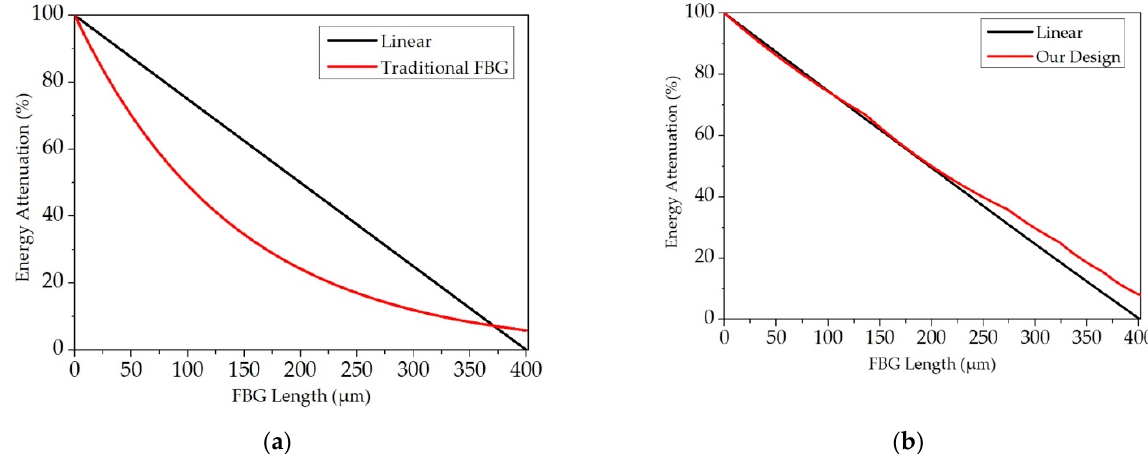
Figure 5 ( a ) The energy attenuation of a conventional grating antenna, where the decay pattern is an exponential decay resulting in less than 50% of the light energy remaining when the light is transmitted to about 100 μ m. ( b ) The multi-variable-width grating antenna for this study can be seen to have a near-linear energy decay pattern.